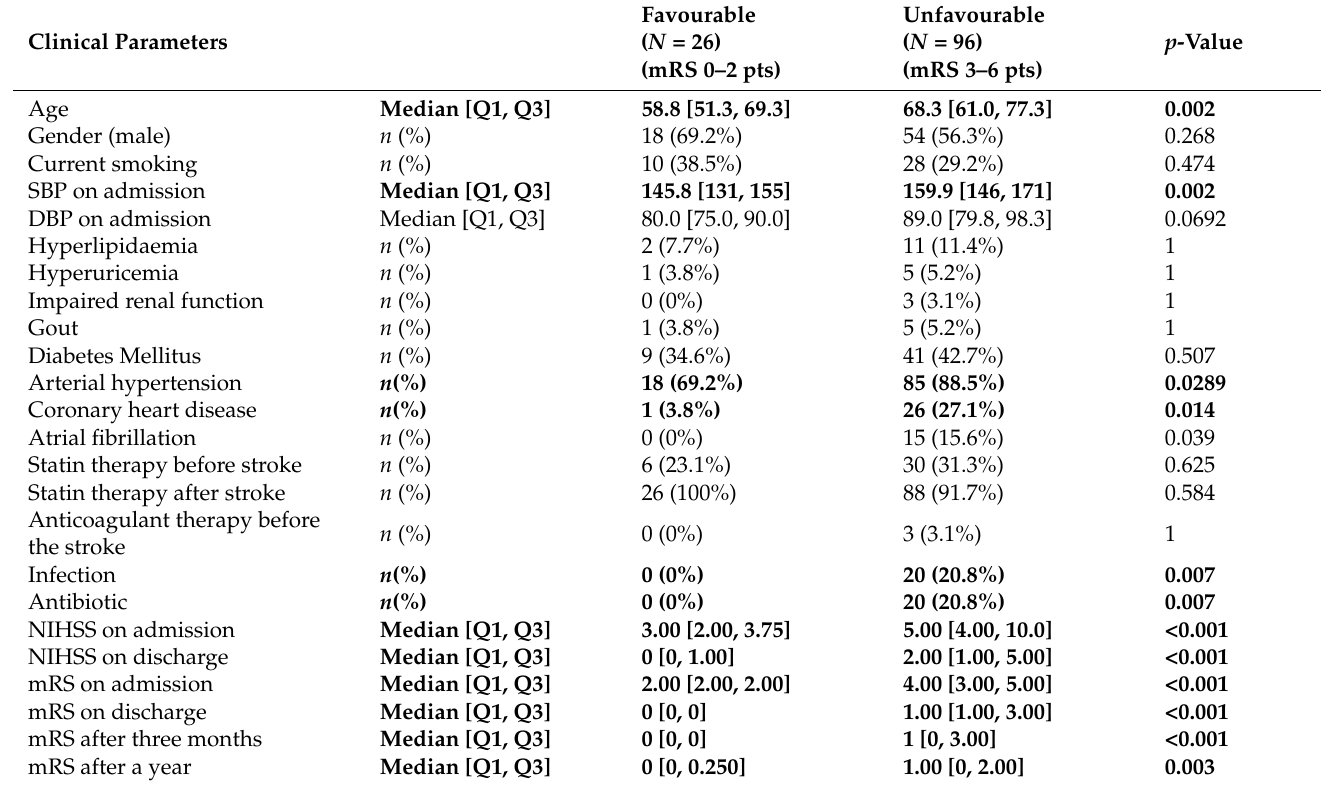
Table 1. The clinical characteristics of stroke patients treated with intravenous thrombolysis at the time of admission to the hospital, including the mRS